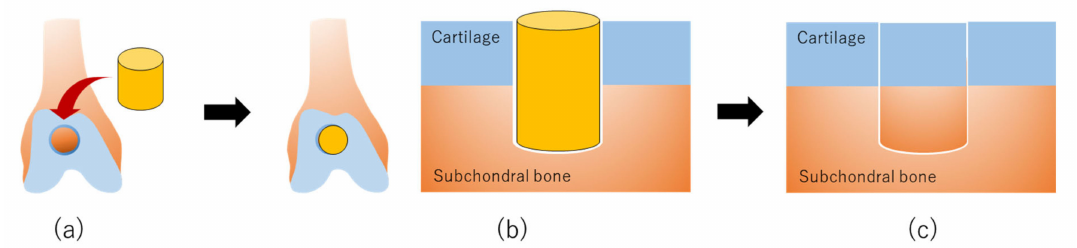
Figure 2. The production of sca ff old-free AT-MSC constructs using the “mold” for osteochondral regeneration in vivo: ( a ) Sca ff old-free cell construct and osteochondral defects are prepared for implantation. ( b ) A sca ff old-free cell construct is implanted into an osteochondral defect. ( c ) AT-MSCs in the construct are di ff erentiated to chondrocytes and osteocytes, followed by regeneration of articular cartilage in the surface layer and formation of subchondral bone in the deep layer at the implanted site. CT images of MMPigs revealed a reduction in the subchondral radiolucent area of the